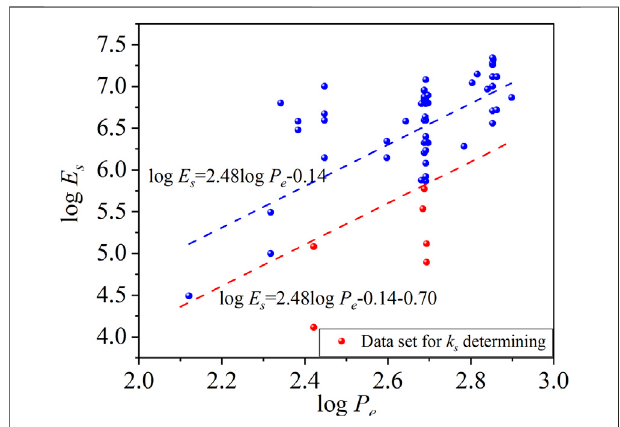
FIGURE 9 | Relationship between microseismic source energy and explosive